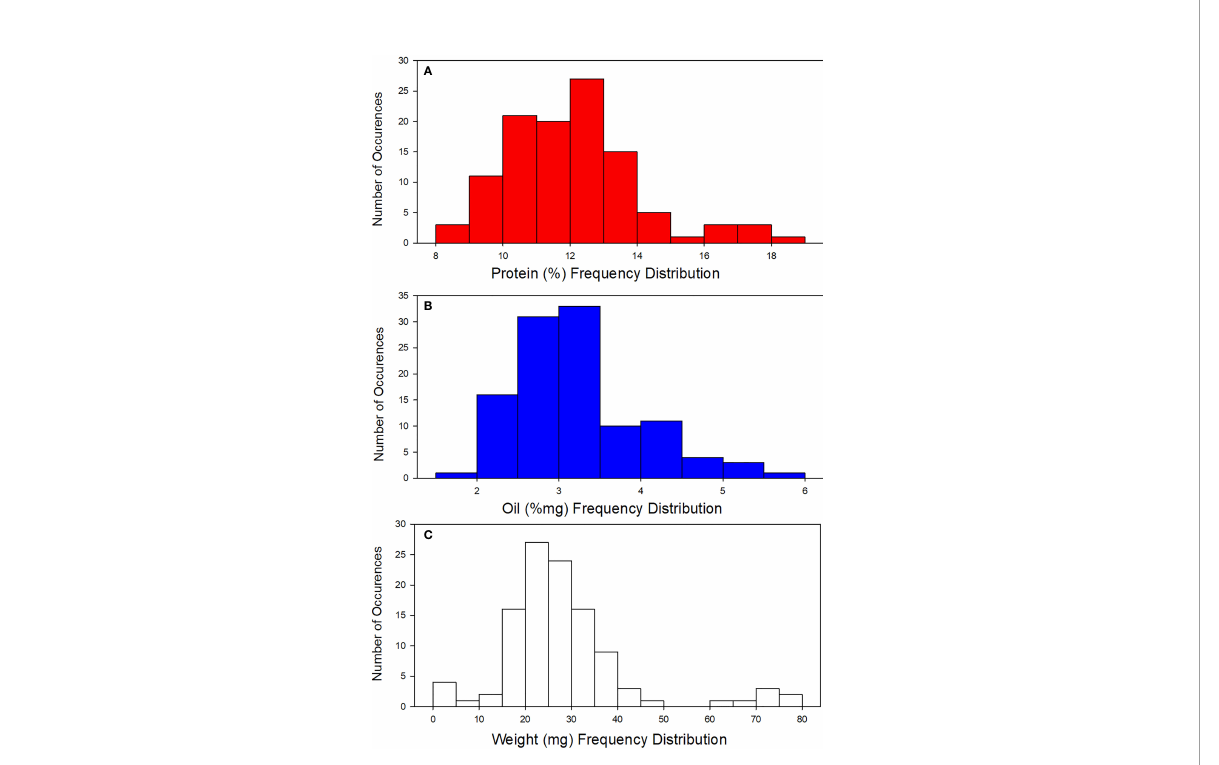
FIGURE 5 Beta-coef fi cient plots based on the optimal PLS models of (A) protein, (B) oil, and (C) weight in single sorghum